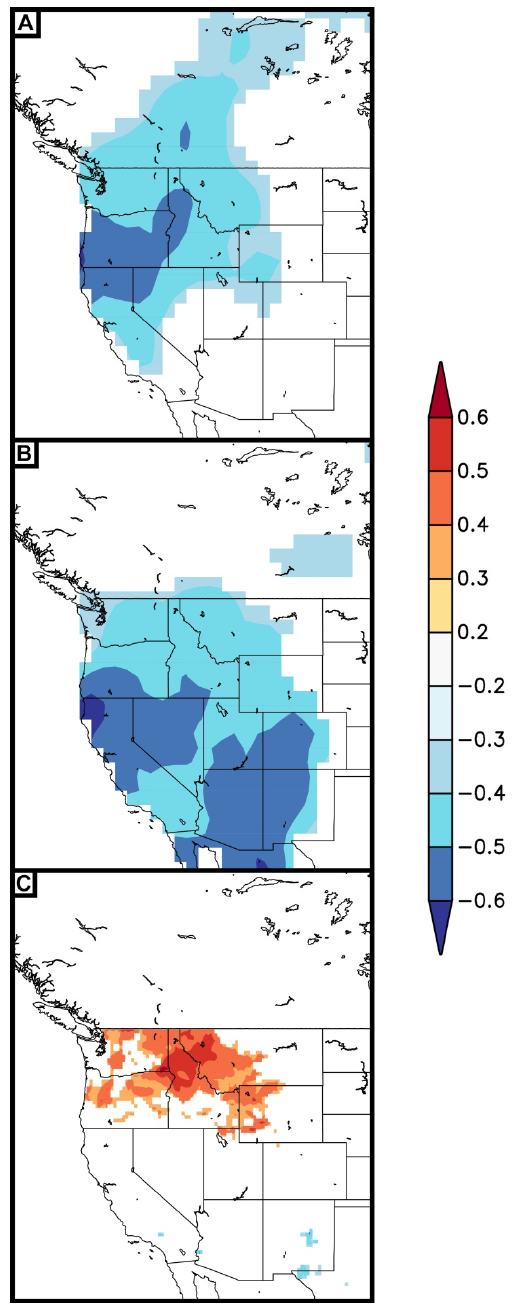
Figure 3. Significant ( p < 0.05) correlations of January ASIE with July: ( A ) maximum temperature; ( B ) minimum temperature and ( C ) precipitation.